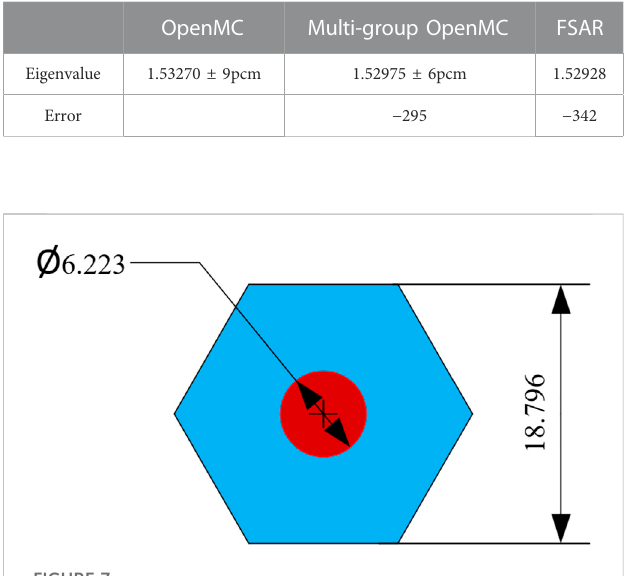
TABLE 2 UO 2 pin cell eigenvalue error.